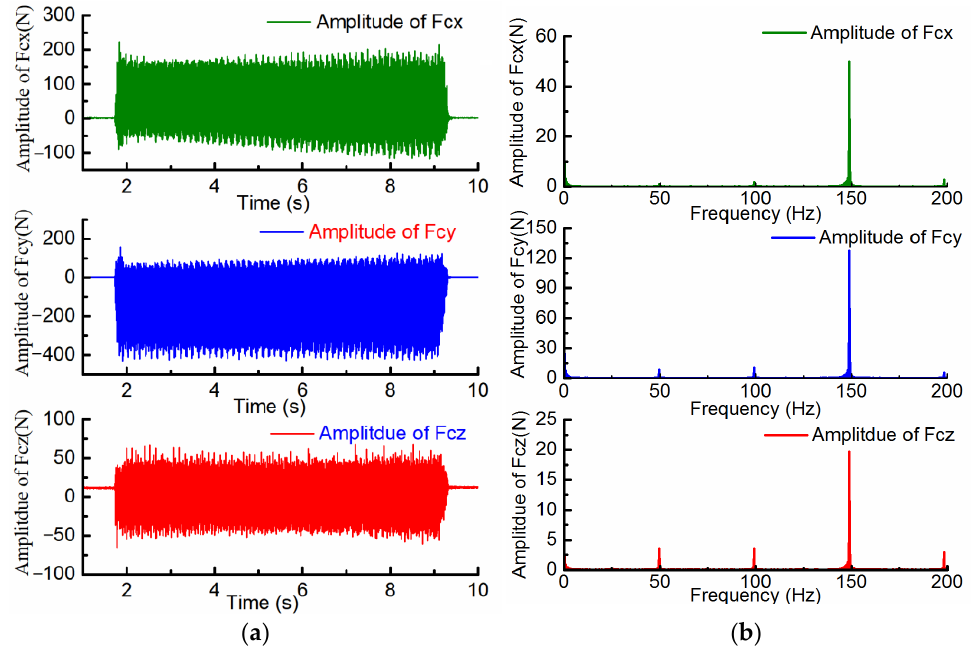
Figure 4. The results of the cutting force in three directions. ( a ) in time domain; ( b ) in frequency domain.